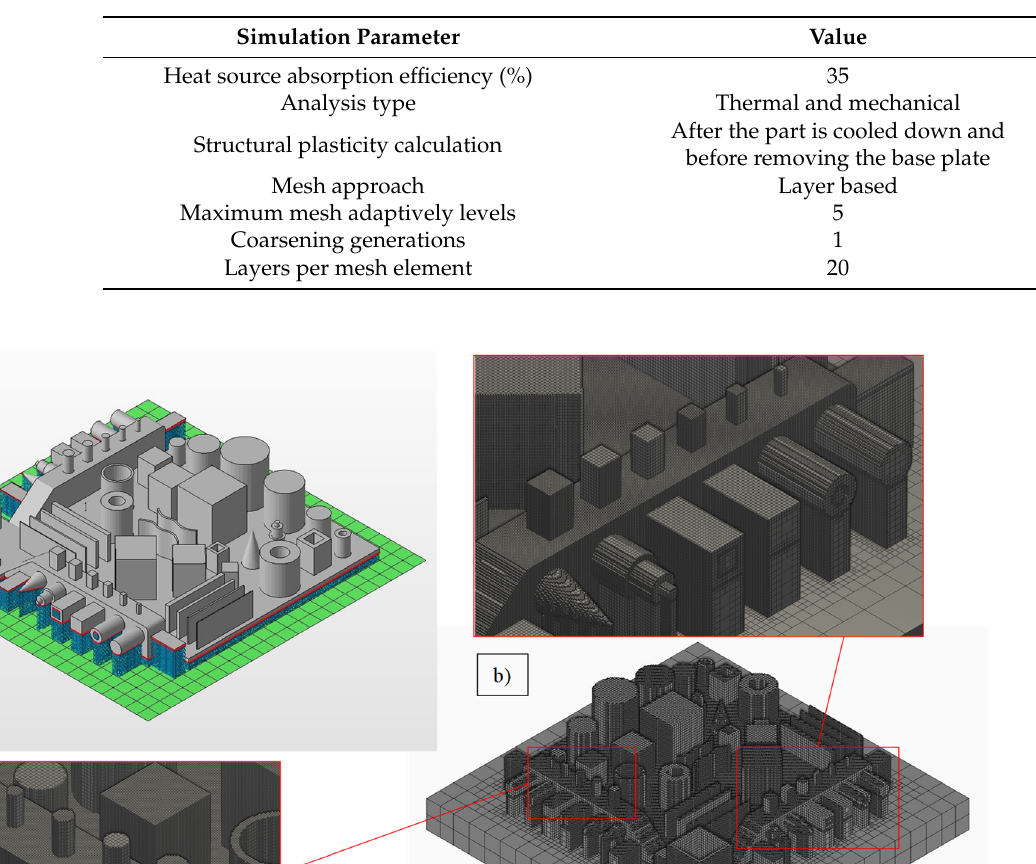
Table 4. Simulation parameters.